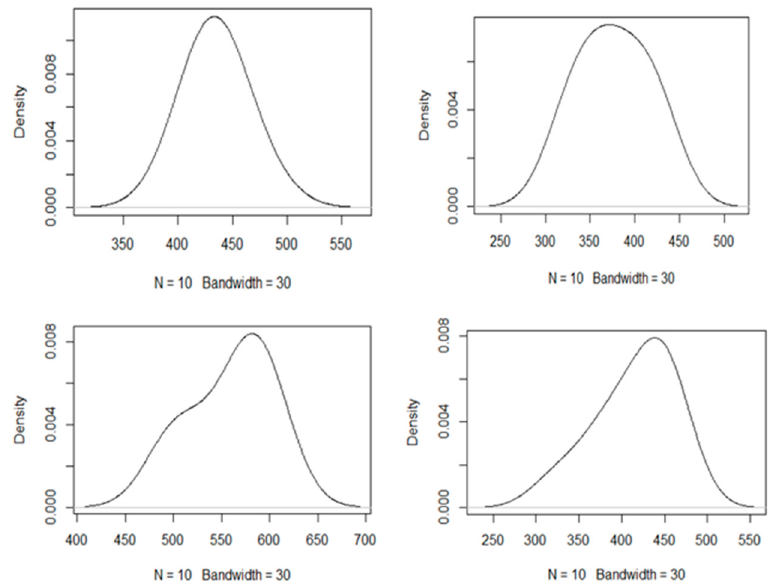
Figure 1. Examples of kernel functions for the PVMATH variable.